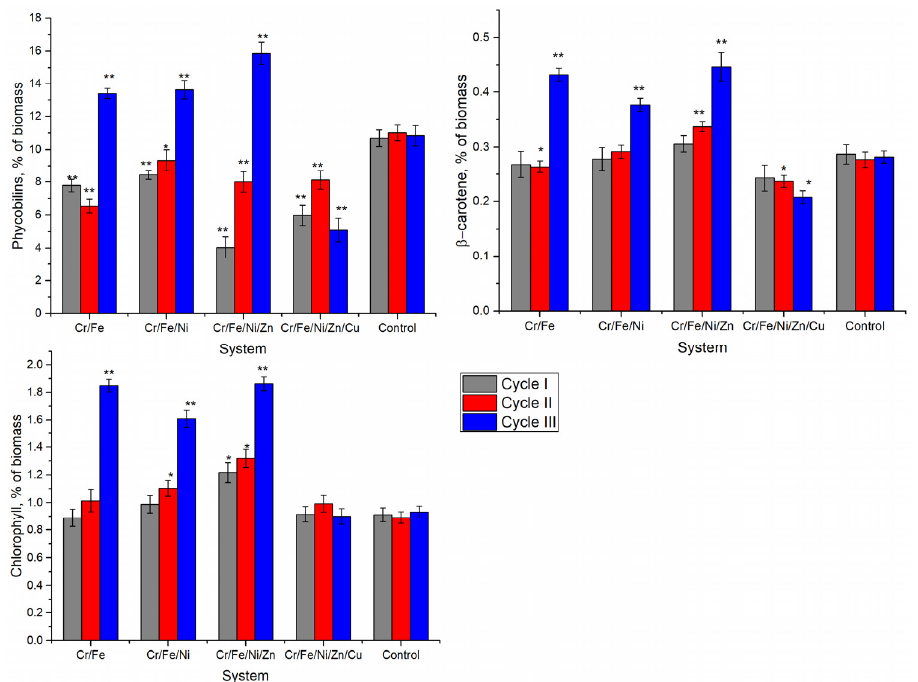
Figure 4. Pigment content (total phycobiliproteins, chlorophyll α , and β -carotene) in Nostoc linckia biomass during three cycles of cultivation media containing multi-metallic systems. (* p < 0.005; ** p < 0.001).